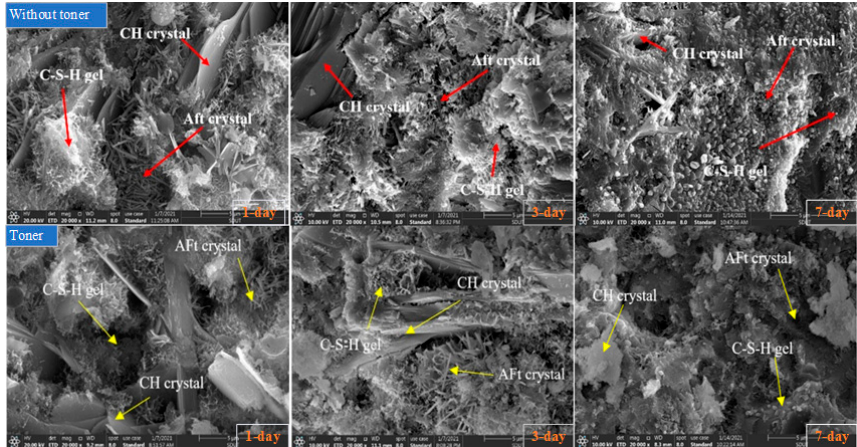
Figure 4. The microstructures of different cement grouting materials.